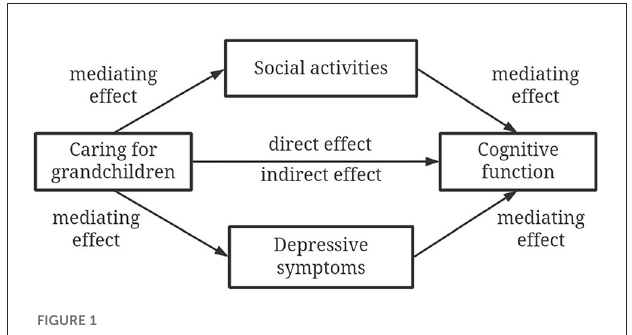
FIGURE1 Hypothesized mediation